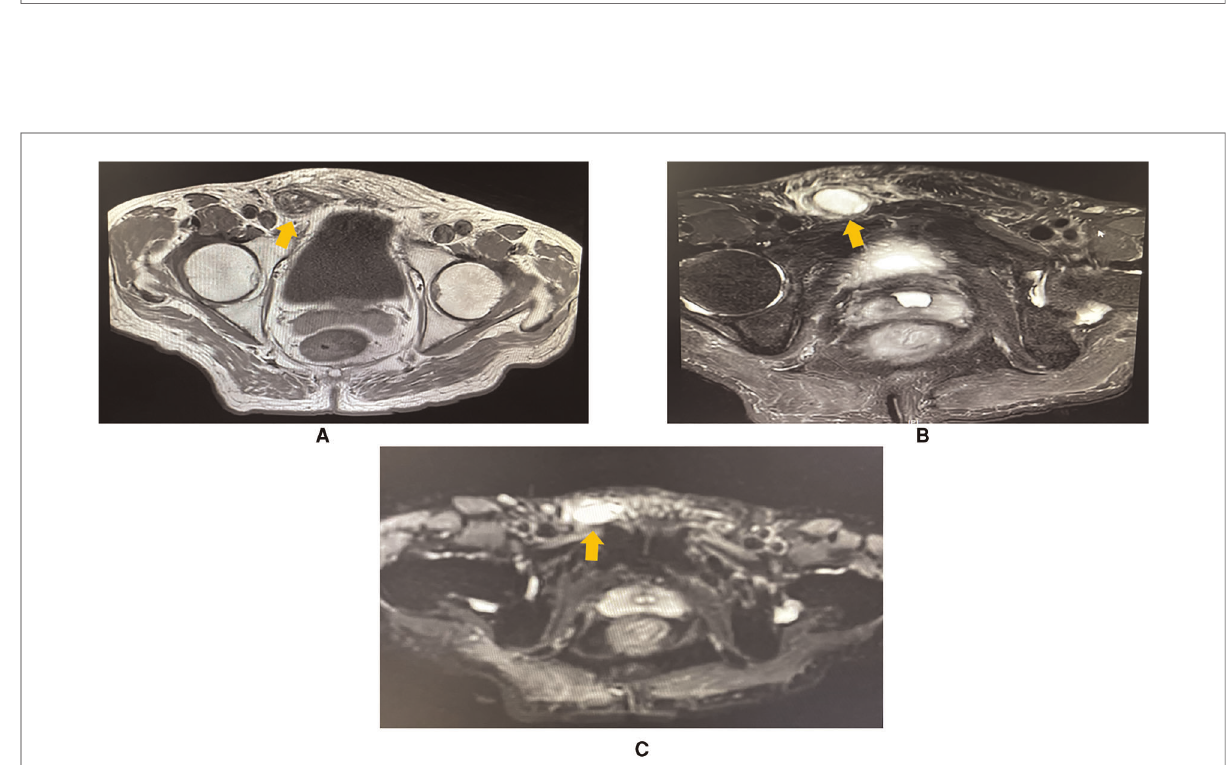
FIGURE 3 MRI imaging (axial plane) showing a 2.3× 1.3 cm oval mass in the right inguinal region, with perilesional effusions and edema. ( A ) T1-weighted imaging showing that the lesion was hypointense (arrowhead). ( B ) T2-weighted imaging showing that the mass (arrowhead) was hyperintense. ( C ) The mass was hyperintense (arrowhead) in diffusion-weighted imaging